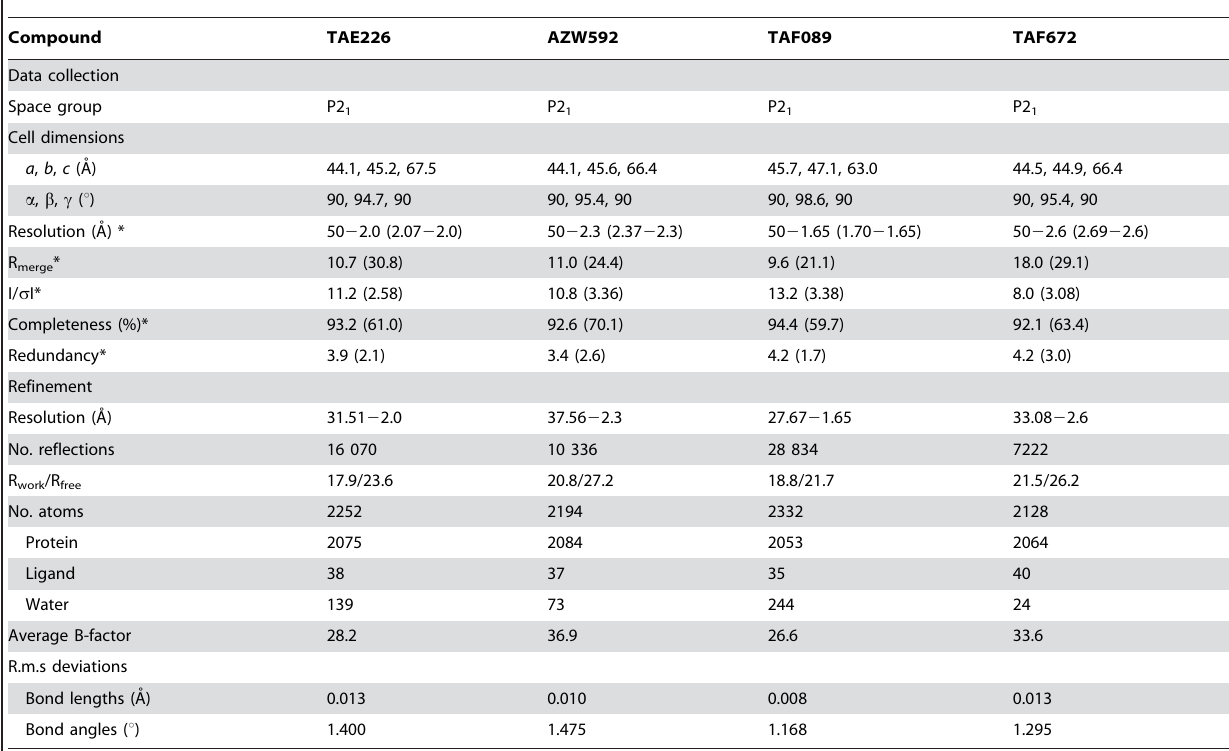
Table 1. Data collection and refinement statistics for FAK/inhibitor structures.